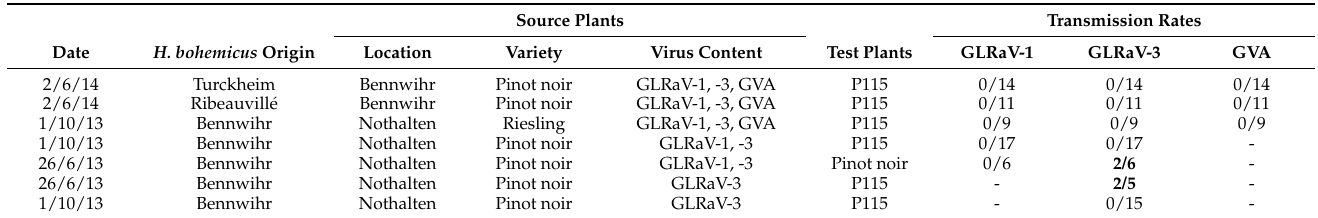
Table 7. Cross transmission experiments by Heliococcus bohemicus L2 nymphs according to the origins of mealybug populations and source vines. For each virus, transmission rate = number of positive vines/number of inoculated vines. Virus transmissions are highlighted in bold.